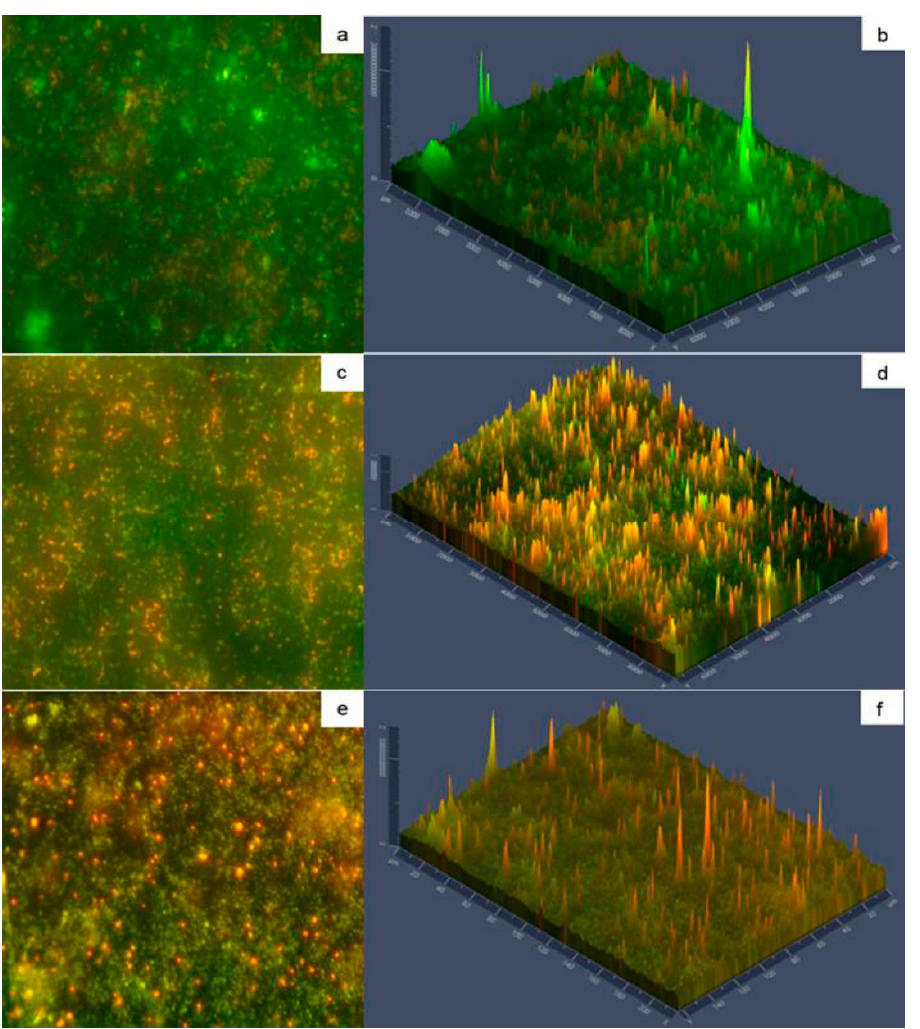
Figure 5. Micrographs of SSP with biofilms on type A deposits ( a , b ) and type B deposits ( c , d ); ELP with biofilms on type A deposits ( e , f ). Green fluorescence indicates viable cells, while red fluorescence indicates damaged cells. Panels ( a , c , e ) show 40X magnification; Panels ( b , d , f ) show fluorescence intensity.